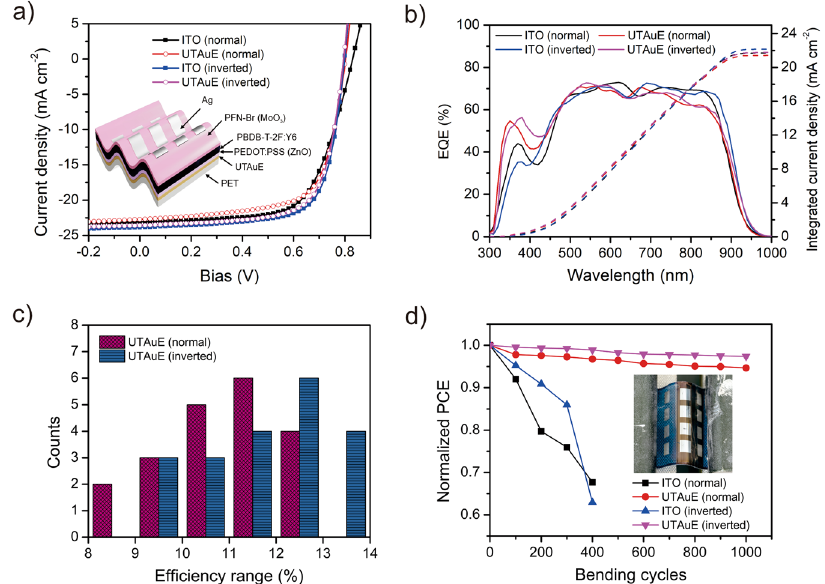
Fig. 4 Performance of OSCs. a J – V curves of the best performing ITO control device and UTAuE-based device. Inset shows the structure of normal and inverted (in bracket) UTAuE-based OSCs. b EQE spectra and integrated J SC of the fl exible ITO and UTAuE-based OSCs. c Statistics of the ef fi ciency range of 40 UTAuE-based OSCs. d Bending retention test of ITO control devices and UTAuE-based devices. The bending radius is 1.5